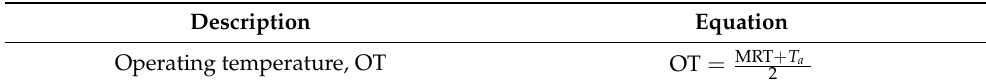
Table 4. Operative temperature